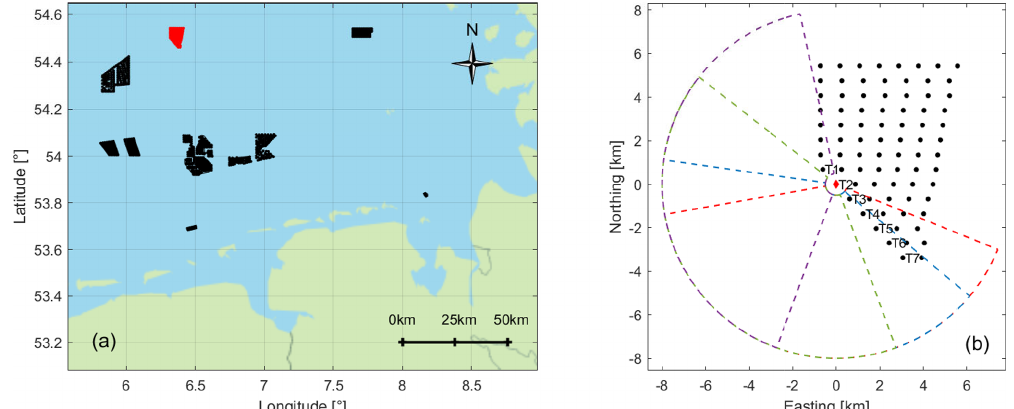
Figure 1. (a) Position of the offshore wind farm Global Tech I (GTI) in red. Other wind farms in the North Sea, which were operational during the measurement campaign, are shown in black. In (b) the layout of GTI is depicted with turbines marked as black dots. The lidar is positioned on the transition piece (TP) of turbine T2 marked in red and defined as the origin of the coordinate system. The four measuring trajectories are depicted in colour. Forecasts were generated for turbines